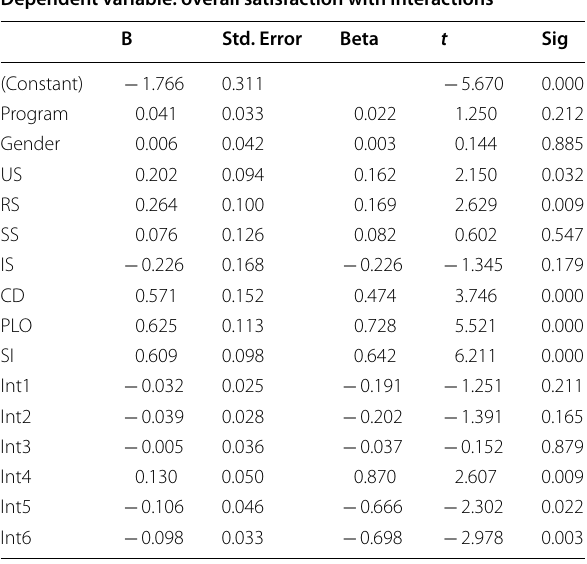
Table 7 Coefficients: OS with Interactions